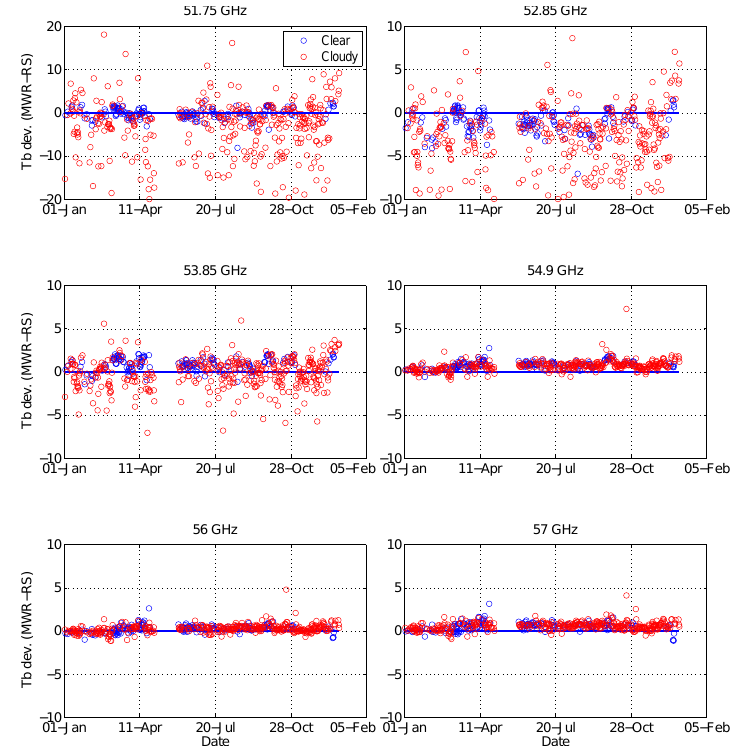
Figure 3. Tb deviation between TEMPERA and RS at 60 ◦ elevation angle for six frequencies.